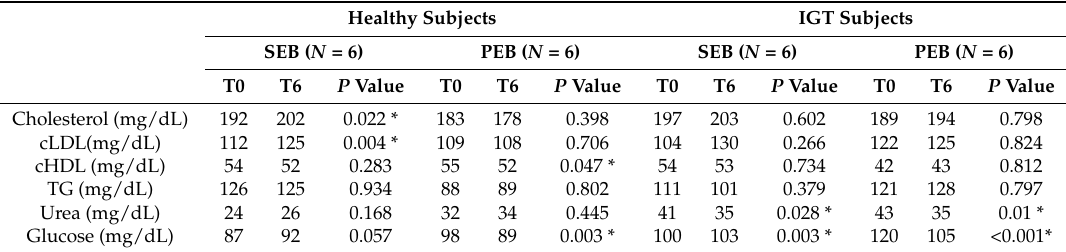
Table 2. Biochemical characteristics of the subjects selected for the proteomic